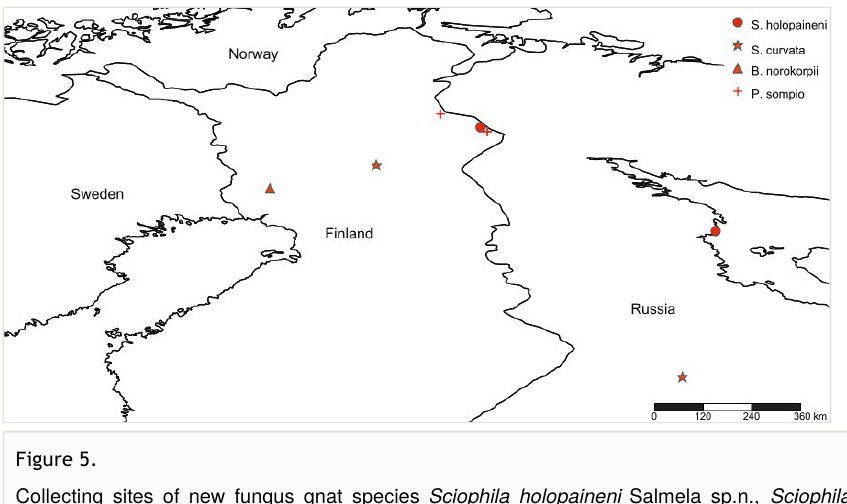
Collecting sites of new fungus gnat species Sciophila holopaineni Salmela sp.n.,